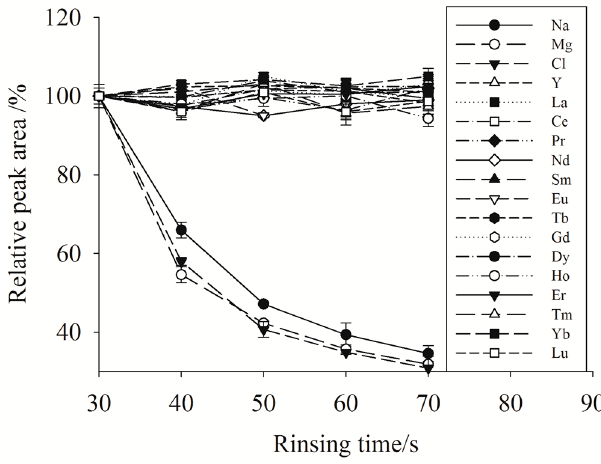
Figure 1. Effect of rinse time on Na, Mg, Cl and YREEs peak areas; test sample salinity = 33. The relative peak areas were normalized to that obtained using a rinsing time of 30 s.